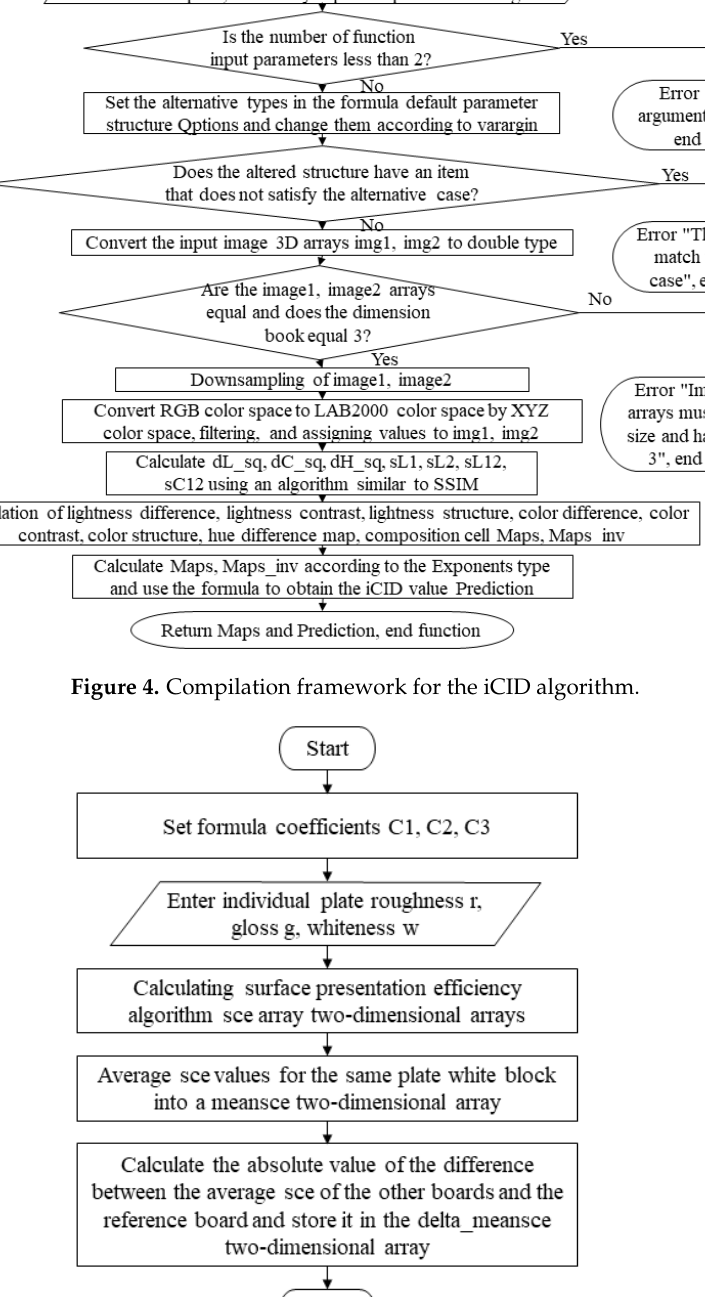
Figure 5. Compilation framework for the proposed SCE algorithm.